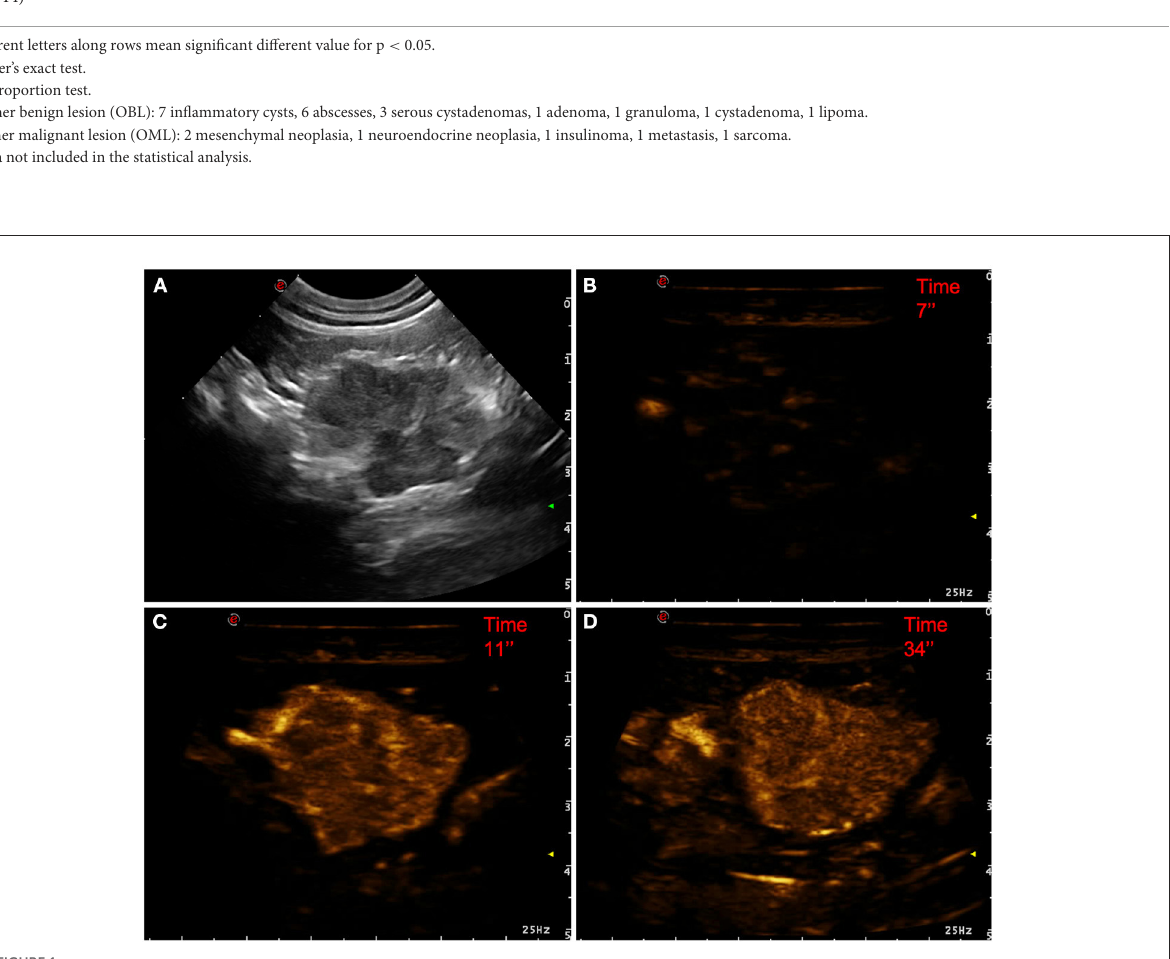
FIGURE1 Example of an adenocarcinoma showing: no pseudocystic appearance, mixed echogenicity, absence of acoustic enhancement, presence of peripancreatic reactivity at US; hyperenhancement, diffused and inhomogeneous distribution of contrast medium, presence of intralesional microcirculation, absence of hypoperfused areas during wash-in at CEUS; no wash-out. (A) Image obtained from US examination; (B) image obtained at TTE; (C) image obtained at TTP; (D) image obtained during